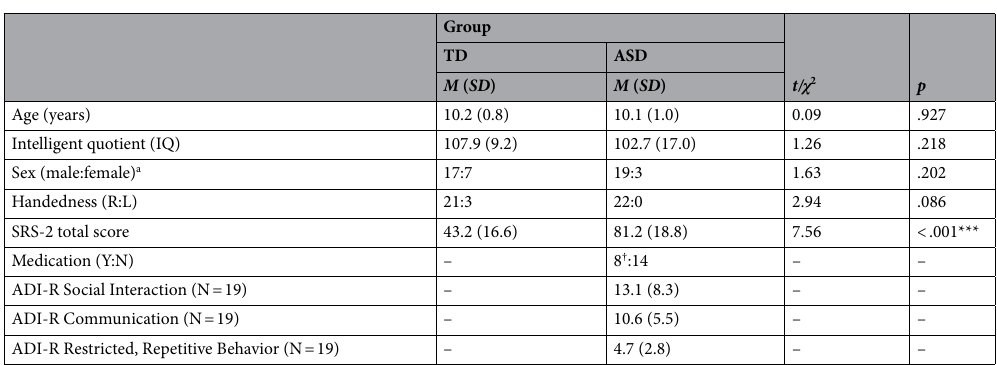
Table 1. Demographic, intellectual, and clinical characteristics of TD (n = 24) and ASD (n = 22) individuals. ADI-R, Autism Diagnostic Interview-Revised; SRS-2, Social Responsiveness Scale–Second Edition. a Group comparison was conducted by the likelihood ratio test. *** p < .001. † Medication for alleviating attention-deficit/ hyperactivity n = 7; antipsychotics for alleviating inflexibility n =